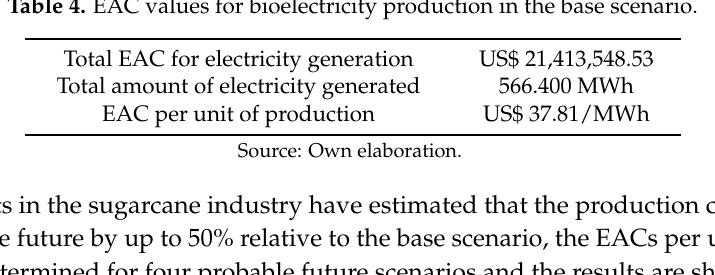
Table 4. EAC values for bioelectricity production in the base scenario.